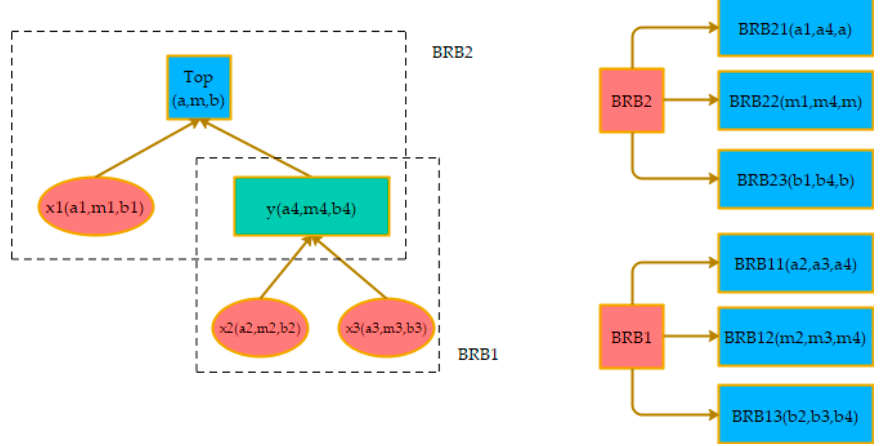
Figure 10. FFTA to BRB Bayesian network transformation diagram.